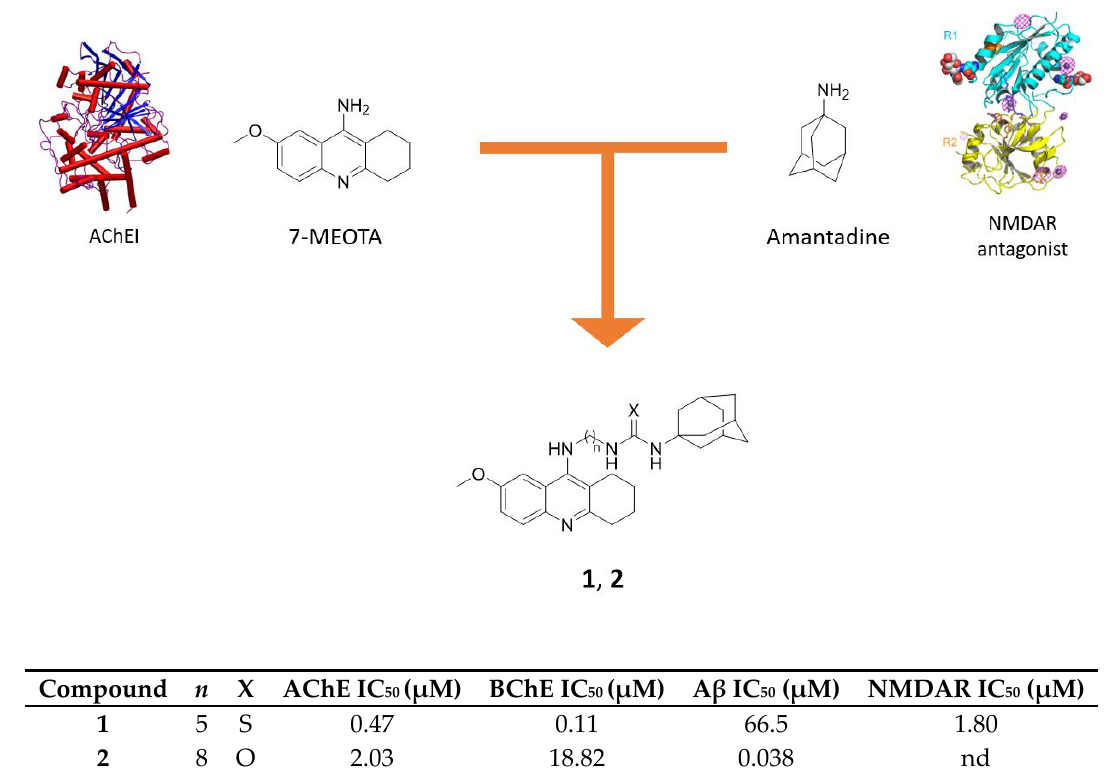
Figure 2. Drug design and biological activities of 7-MEOTA-amantadine hybrids 1 and 2 .